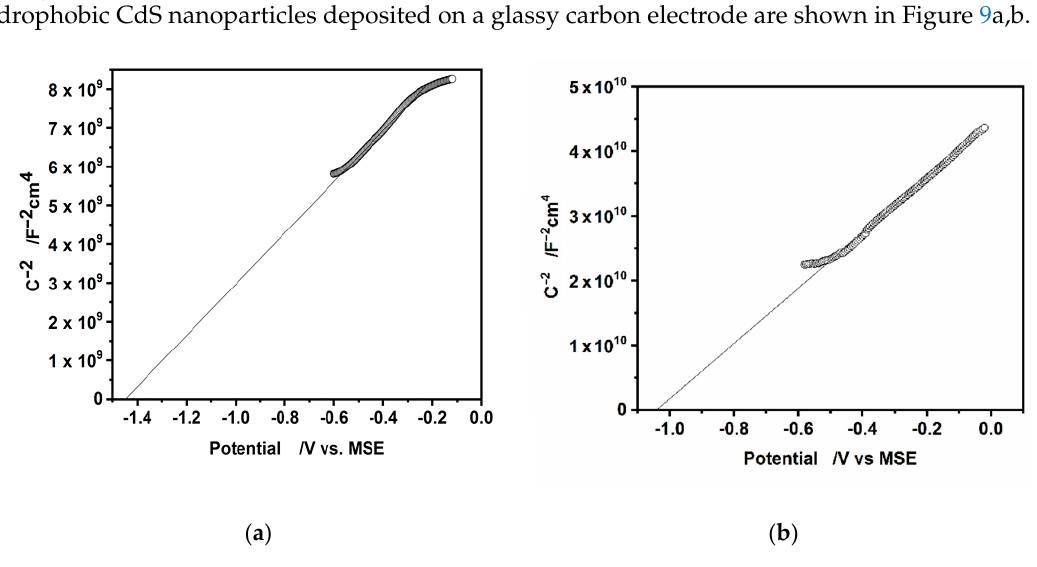
Figure 9. The Mott-Schottky plots for ( a ) hydrophilic and ( b ) hydrophobic, oleylamine-coated CdS nanoparticles. Potentials are quoted vs. MSE electrode. nanoparticles. Potentials are quoted vs. MSE